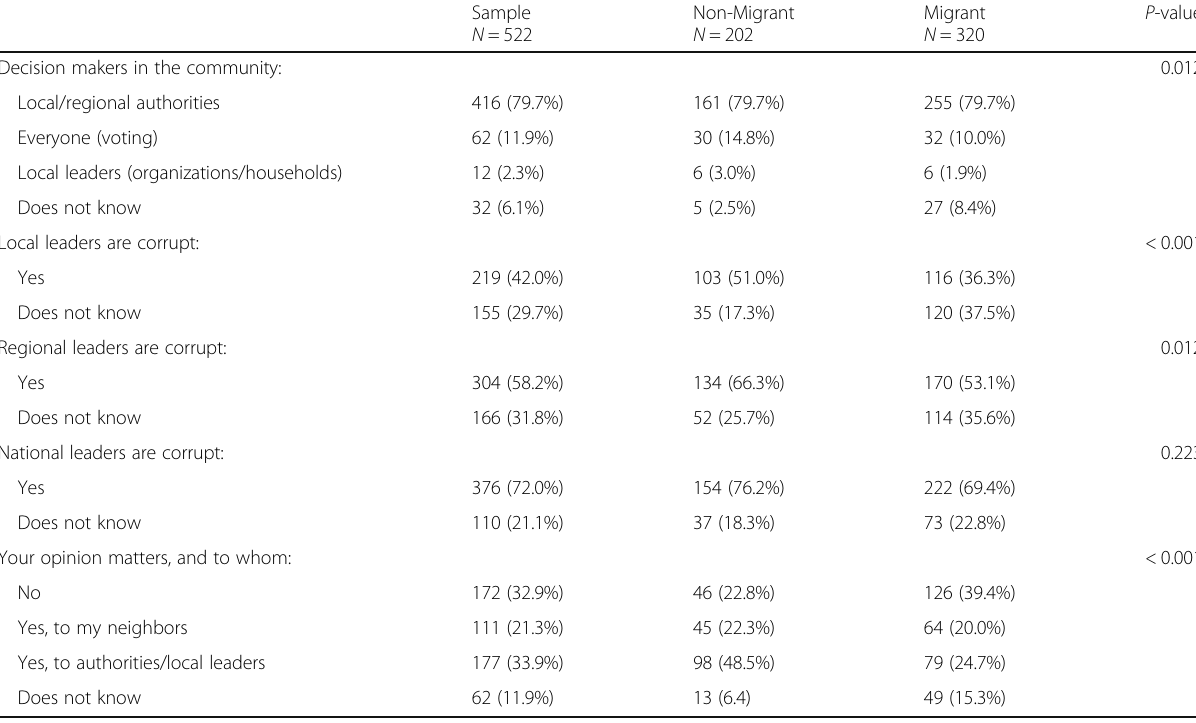
Table 10 Perceptions of community